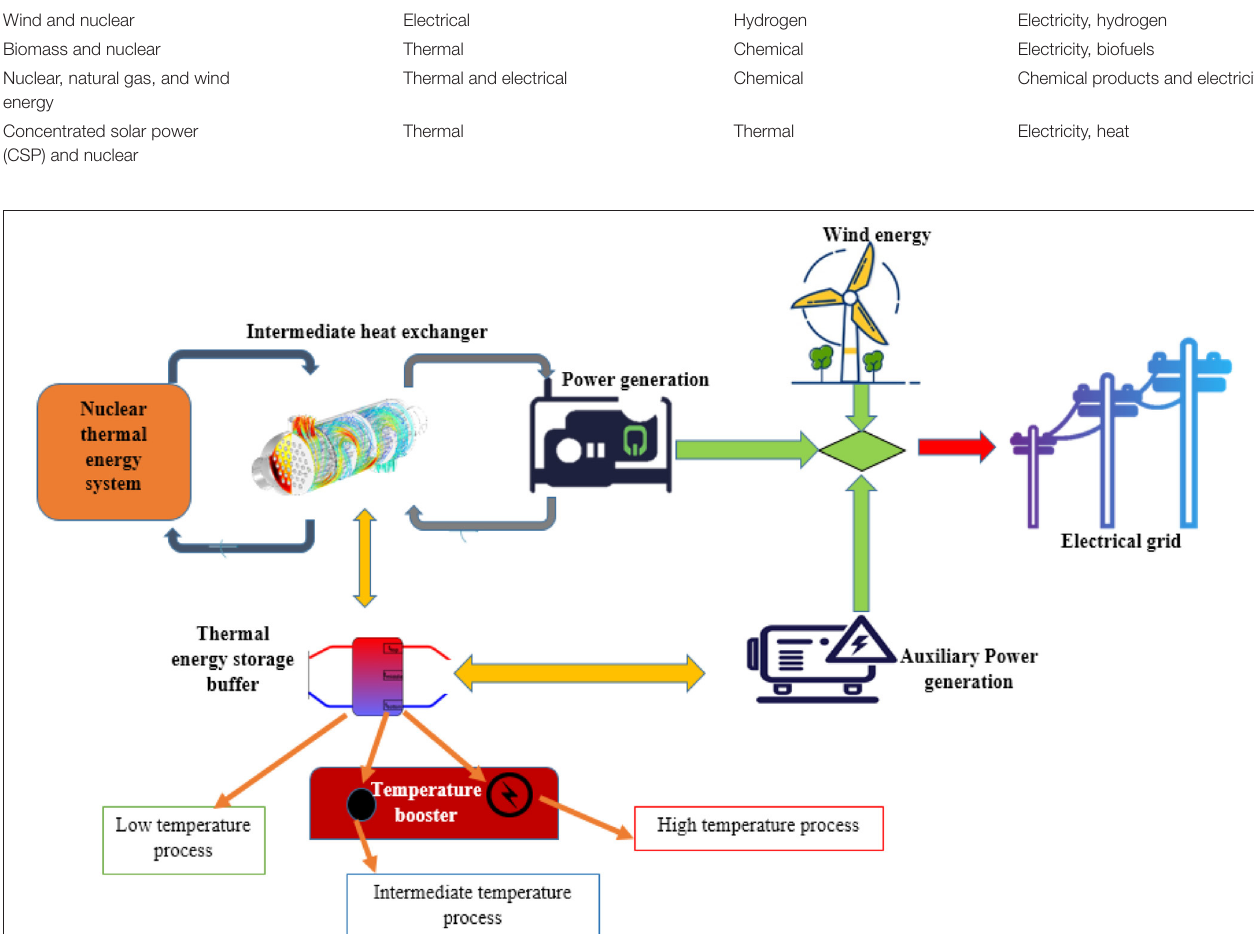
FIGURE 3 | Configuration of nuclear-wind hybrid energy